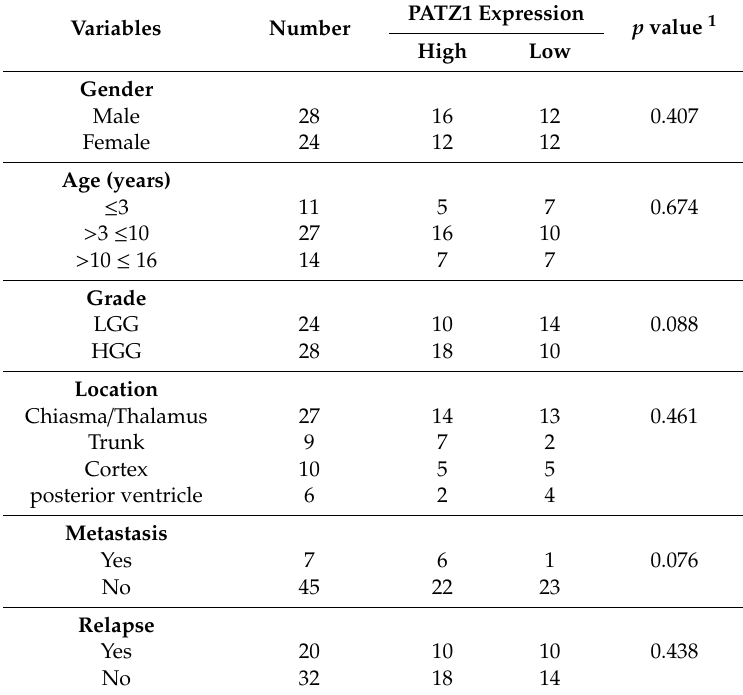
Table 3. Correlation between PATZ1 expression and clinicopathological characteristics of pediatric glioma patients ( n =